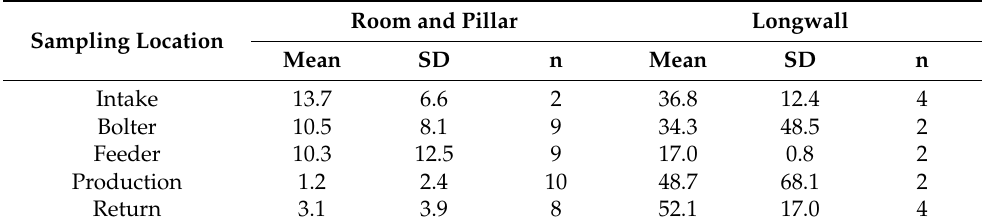
Table 4. FTIR mean calcite mass % and standard deviation (SD) for RCMD samples (excluding Mines 19 and 20) grouped by sampling locations and mining method. As for Figure 5, results were averaged in cases where multiple samples were available in the same mine x